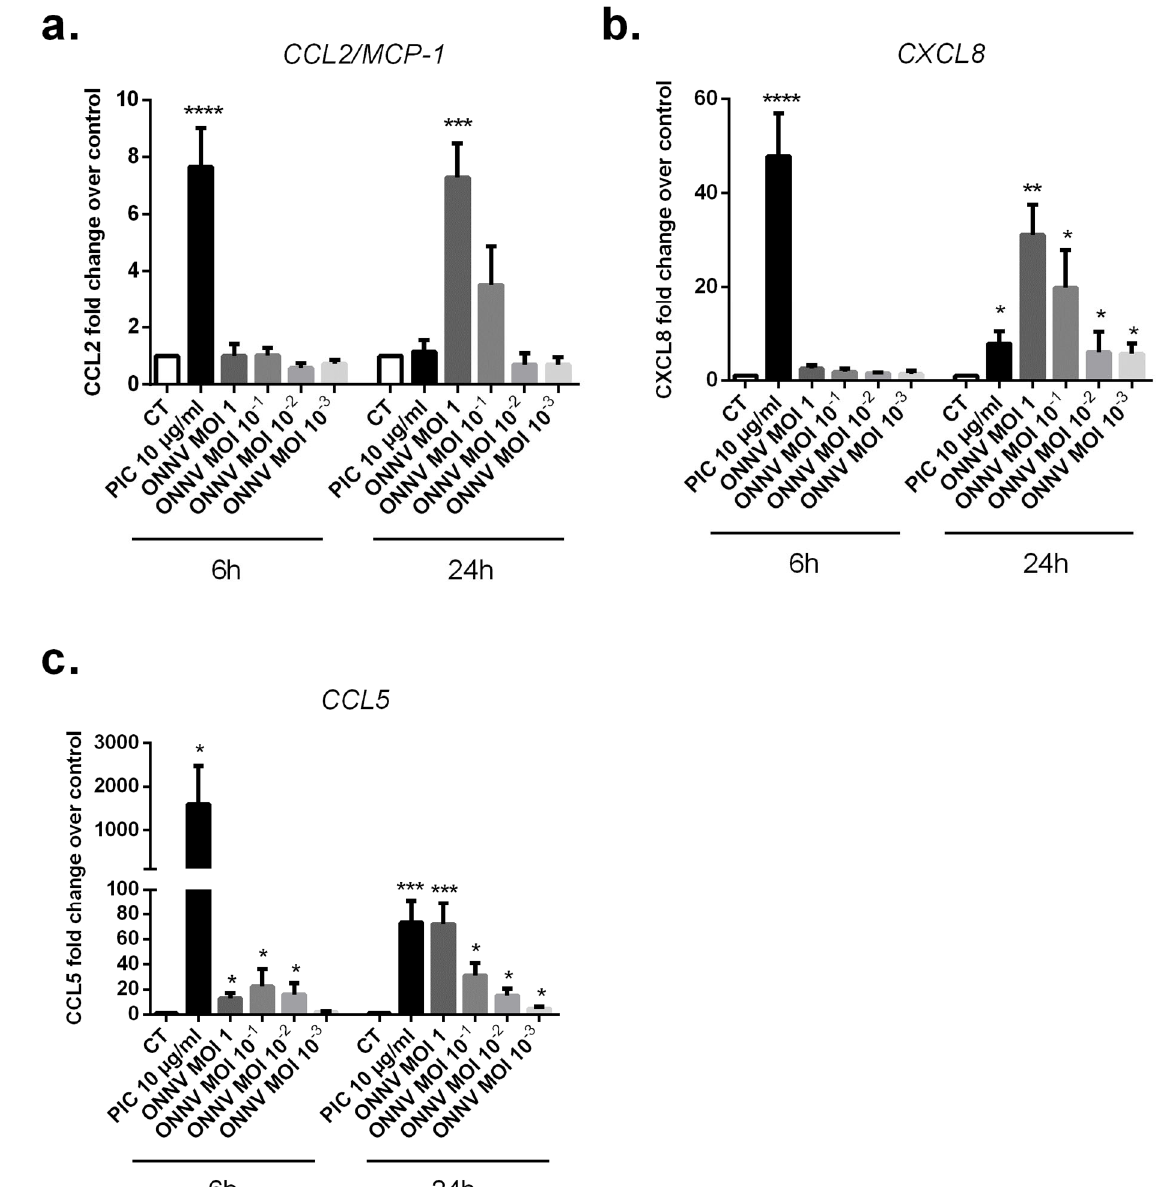
Figure 5. Marked upregulation of proinflammatory chemokines by SC in response to ONNV infection and PIC stimulation. ( a ) CCL2, ( b ) CXCL8, and ( c ) CCL5 mRNA levels from SC after ONNV (MOI 10 − 3 to 1) infection or exposure to PIC 10 μ g/mL for 6 h and 24 h, as measured by qRT ‐ PCR. All experiments were done in quadruplicates. Results are expressed as mean ± SEM and presented as a normalized fold increase vs. control (CT). * p ‐ values ≤ 0.05, ** p ‐ values ≤ 0.01, *** p ‐ values ≤ 0.001, and **** p ‐ values ≤ 0.0001 represent significant differences from controls by one ‐ way ANOVA followed by the Bonferroni’s test analysis.